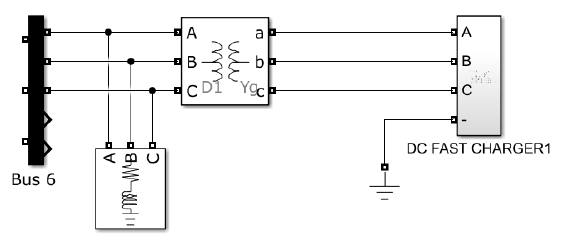
Figure 2. A 6-bus system EV charging station